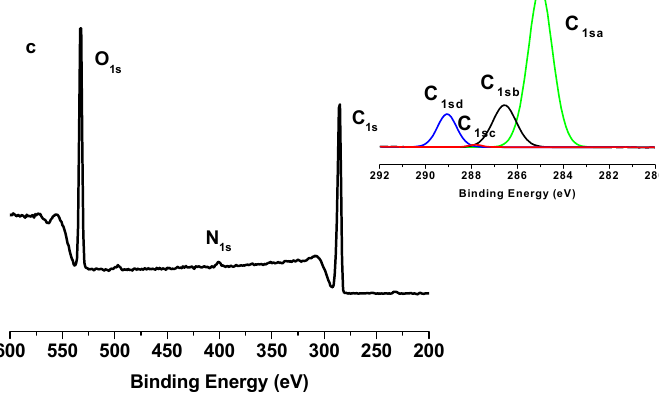
Table 1. C narrow scan X-ray photoelectron spectroscopy (XPS) spectra for TONC, 1s